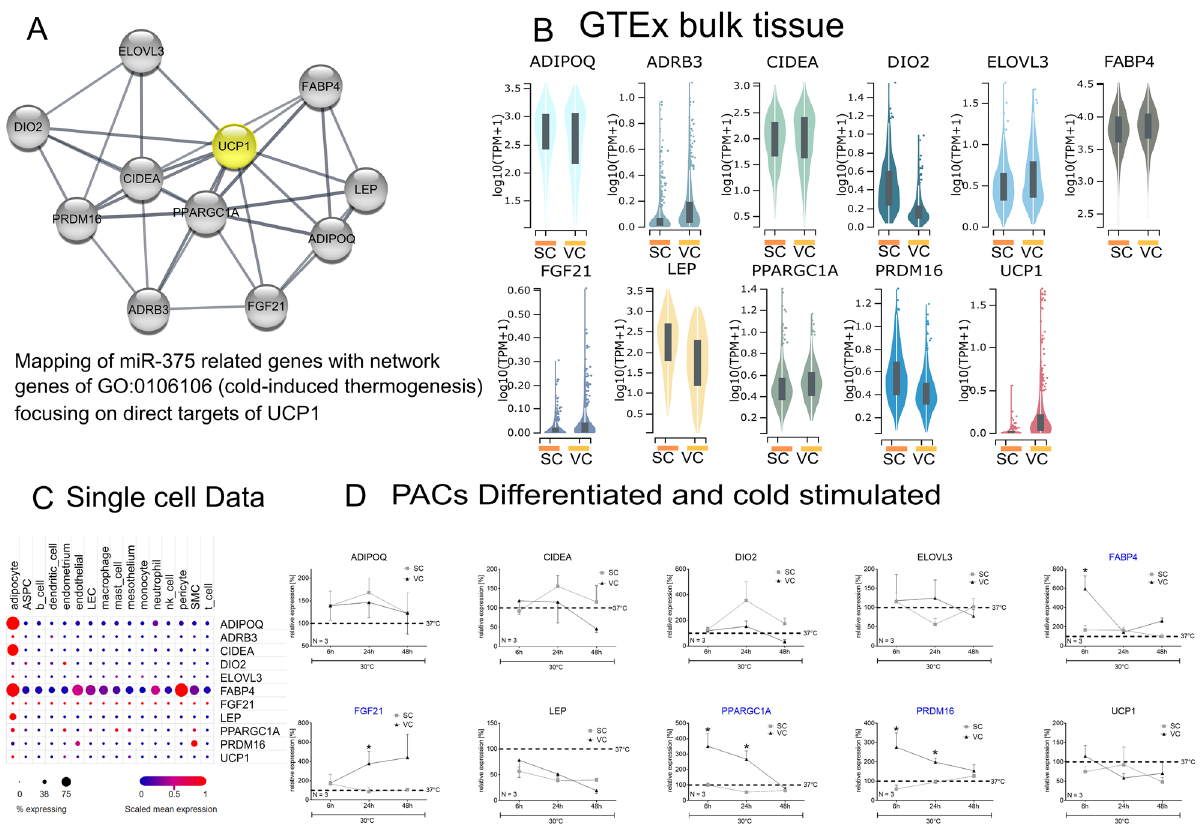
Figure 2. miR-375 related genes are thermogenesis associated and were differently regulated in VAT / SAT and cells. ( A ) Network of predicted miR-375 target genes involved in the adaptive cold induced-thermogenesis pathway, focusing on direct targets of UCP1. ( B ) Overall gene expression differences of the network genes between SAT and VAT adipose tissue, data originates from the “Genotype-Tissue Expression” project. ( C ) Using single-cell RNA read outs from the Single Cell Portal (study no. SCP137) gene expression levels of the network genes were displayed. ( D ) Comparison of PACs of different origin after acute cold stimulation revealed only for VC-PACs a response detectable in the up-regulation of the identified network genes FABP4, FGF21, PPARGC1A and PRDM16 ( *P < 0.05 ). Data are normalized to relevant housekeeping genes and shown as mean ± SEM. SC = subcutaneous, VC =